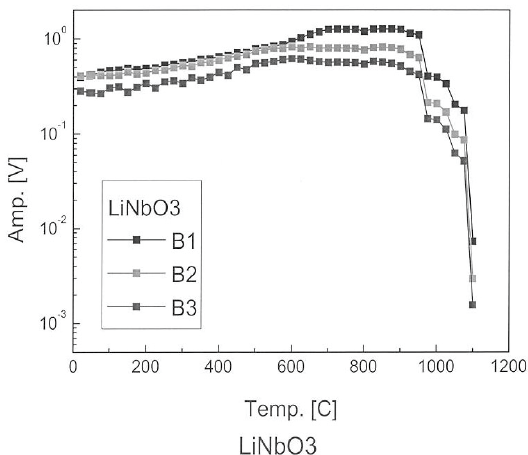
Figure 1. Temperature profiles for pulse-echo amplitude of lithium niobate (LiNbO 3 ) single crystal bonded to steel. B1, B2, and B3 describe three successive runs [1].